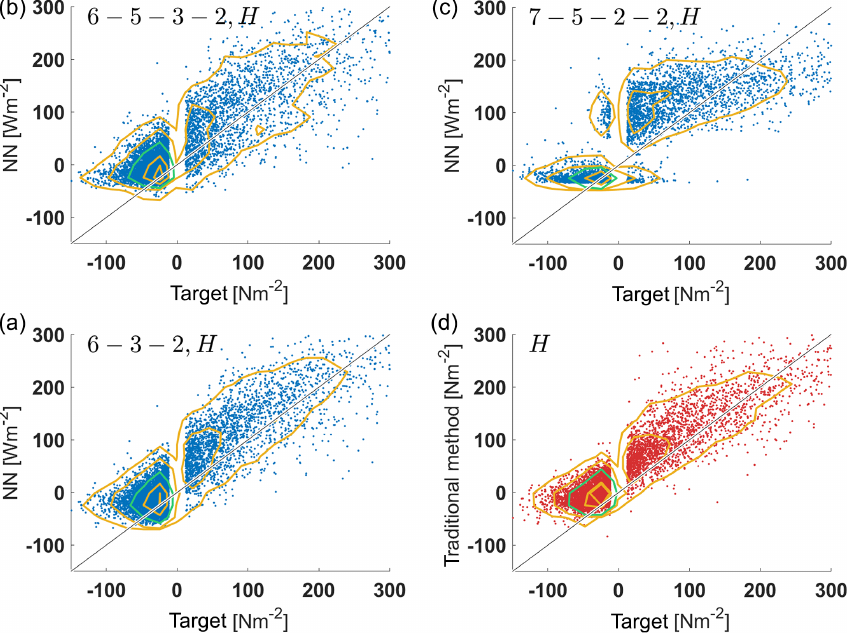
Figure 6. Plots of network output vs. target values for heat flux on unknown test data (DE-Keh). The 6–3–2 ANN ( a ), 6–5–3–2 ANN ( b ), 7–5–2–2 ANN ( c ) and the MOST method ( d ) are shown. Contours represent the kernel density estimates of the two-dimensional probability density distribution with the 95th, 75th, 25th and 5th percentiles (yellow contours – starting from the outermost contour) and the 50th percentile (green contour). The vertical gap is due to the exclusion of heat fluxes between ± 10Wm − 2 .